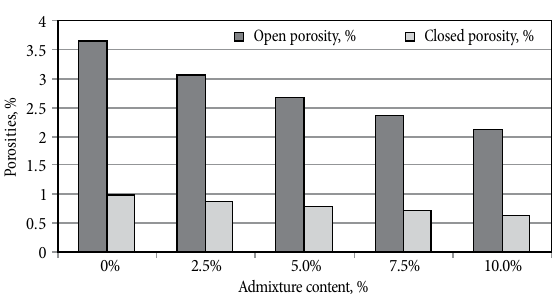
Fig. 6. Function of closed and open porosity and amorphous alumina silicate admixture content